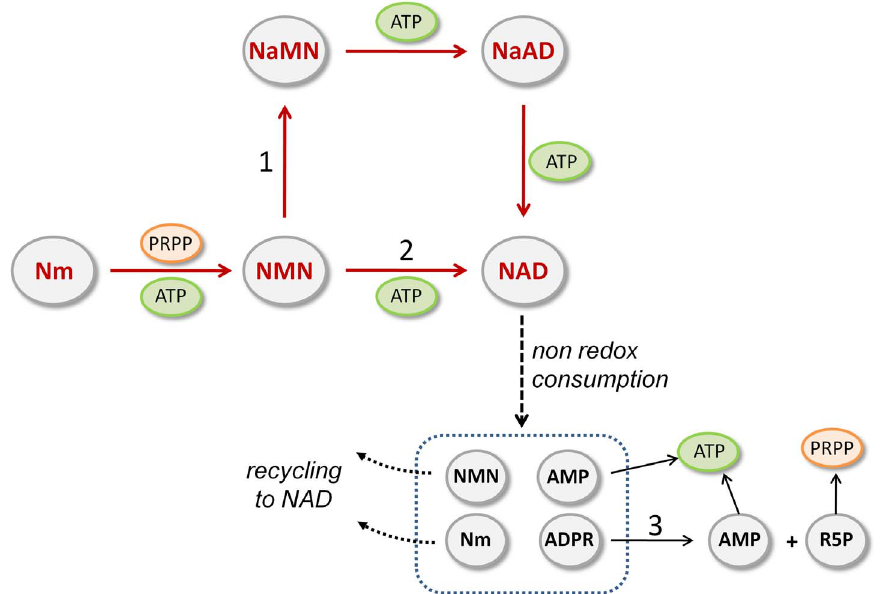
Figure 1. Recycling of bacterial NAD catabolism products. Reactions described in this study, numbered from 1 to 3, are catalyzed by: 1) NMN deamidase (PncC); 2) NMN adenylyltransferase of the NadM family; 3) ADPR pyrophosphatase. In several bacterial species PncC and NadM occur in fused forms with COG1058 ADPRP and Nudix ADPRP, respectively, as discussed in this work. Abbreviations: Nm, nicotinamide; NMN, nicotinamide mononucleotide; NaMN, nicotinate mononucleotide; NaAD, nicotinate adenine dinucleotide.